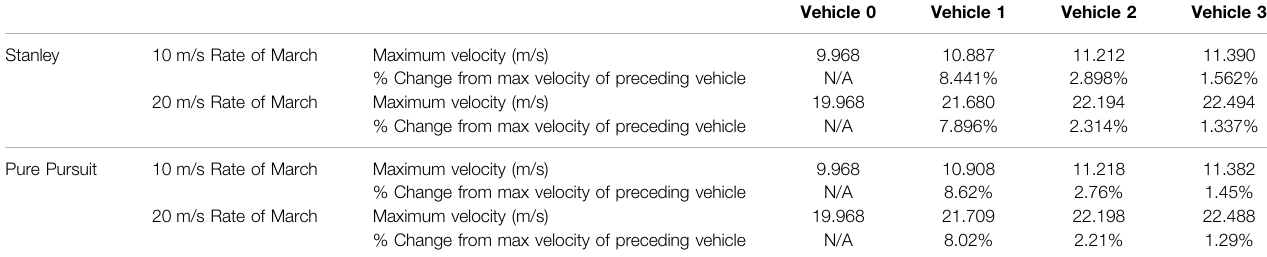
TABLE 7 | Maximum vehicle velocities for different Rate of March settings.